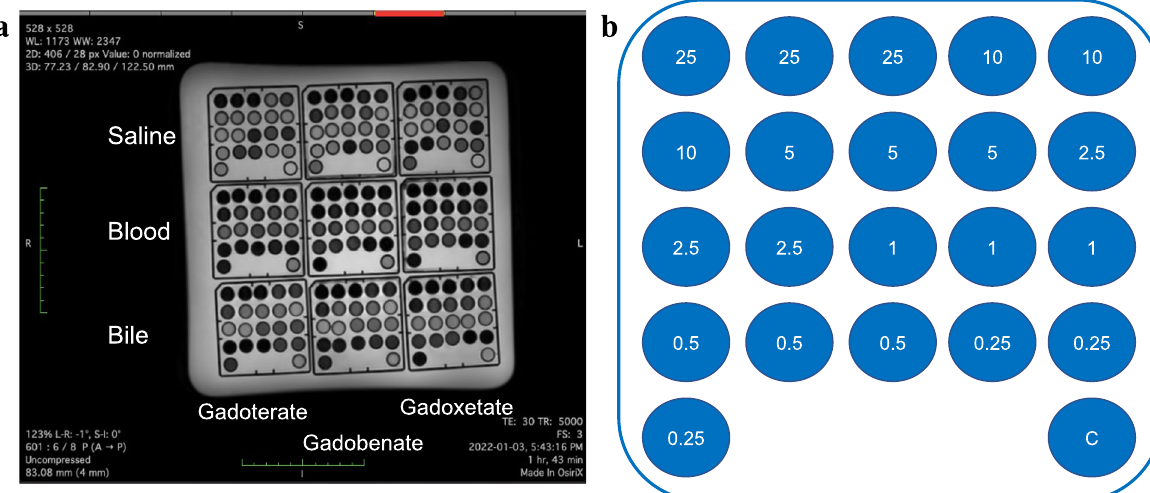
Fig. 1 Experimental set‑up. The vials containing contrast agents gadoterate (left column), gadobenate (middle column), and gadoxetate (right column) in saline (top row), blood (middle row), and bile (lower row) were placed in a sample holder and submerged in water at room temperature. The samples were then imaged using different sequences (here: fluid‑attenuated inversion‑recovery sequence) ( a ). The concentration of the contrast agents ranged from 0.25 to 25 mM, and each sample contained a control vial on the lower right with saline instead of the contrast agent ( b )